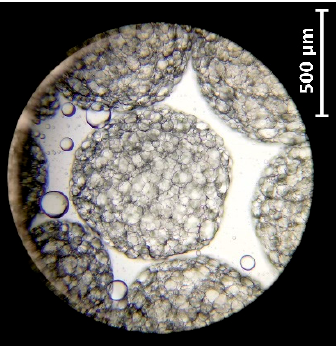
Figure 4. Microscopic image of oil-loaded Ca-alginate beads at a magnification of